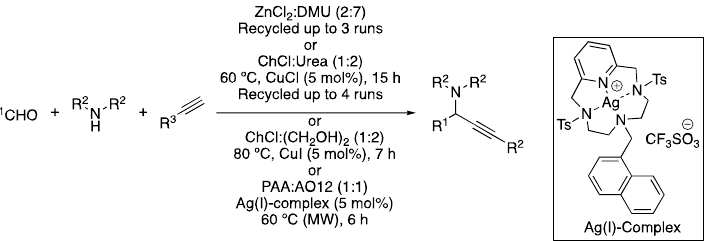
Figure 34. Examples of A 3 -coupling in DESs.